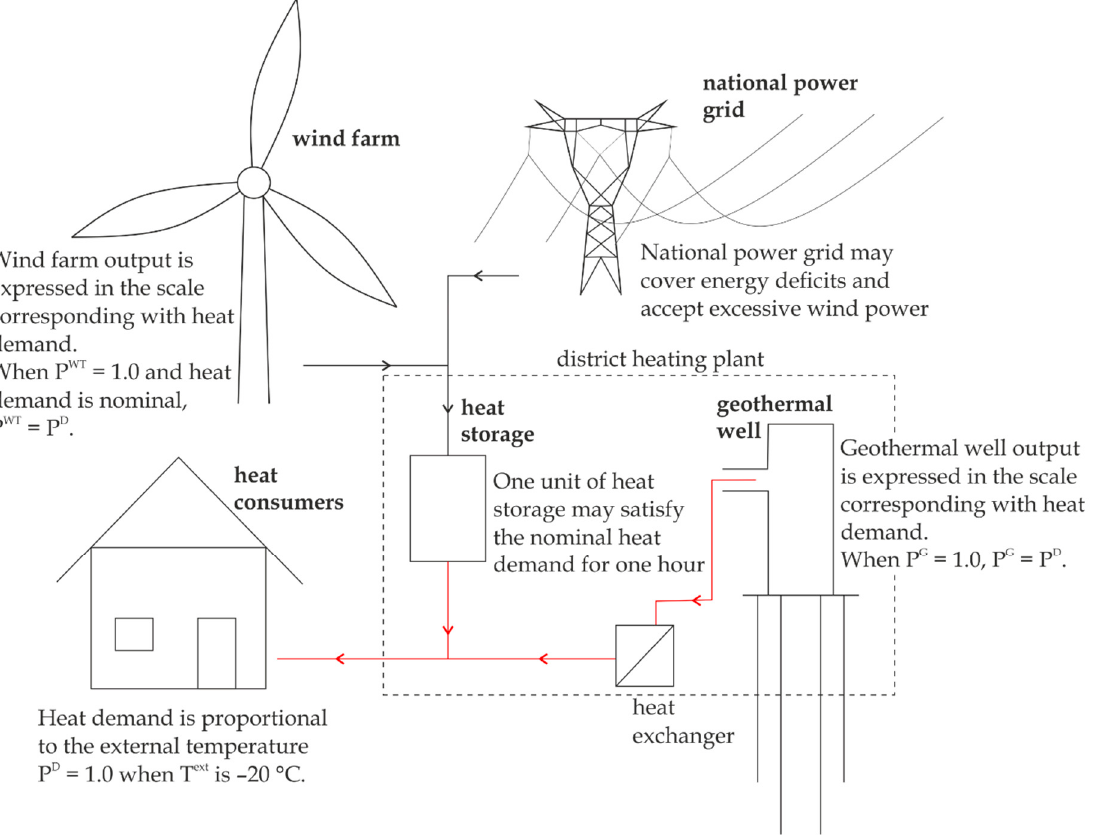
Figure A1. Conceptual design of the geo-wind system with corresponding heat and electricity flow.